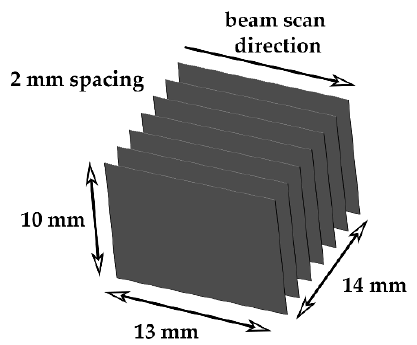
Figure 3. Illustration of the single melt track width geometry with 2.0 mm spacing. Powder was harvested from between the wafers in a serial fashion, as a function of the distance from the solid copper